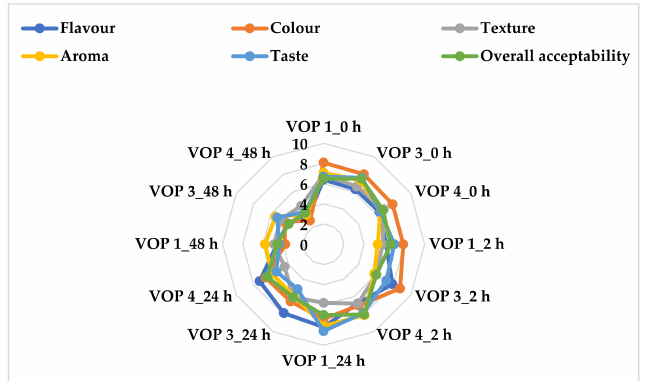
Figure 2. Sensory evaluation of fermented and unfermented cowpea leaf smoothies. VOP 1, VOP 3, and VOP 4 = cowpea cultivar leaf smoothies; LAB 75 = Ltp. Plantarum 75; VOP 1_0 h, VOP 3_0 h, and VOP 4_0 h = pasteurized and unfermented smoothies; VOP 1_2 h, VOP 3_2 h, and VOP 4_2 h = 2 h-fermented smoothies; VOP 1_24 h, VOP 3_24 h, and VOP 4_24 h = 24 h-fermented smoothies; VOP 1_48 h, VOP 3_48 h, and VOP 4_48 h = 48 h-fermented